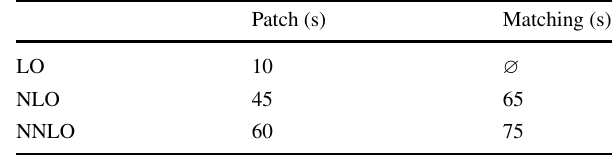
Table 2 Selected PDF sets with their respective number of members Set